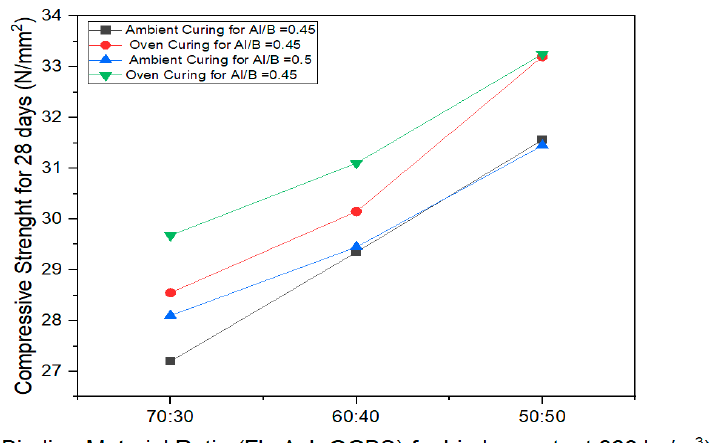
Figure 11. Compressive strength of GPC of 400 kg/m 3 for 7 days.